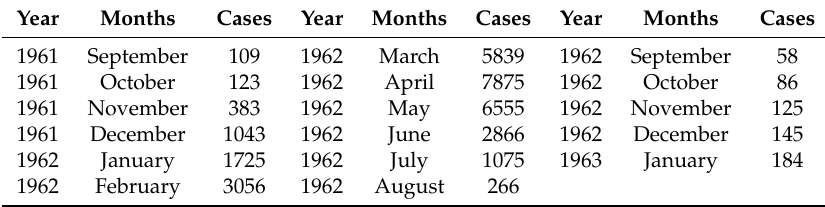
Table A1. Reported infections of measles from September 1961 to January 1963 in New York, USA [57].